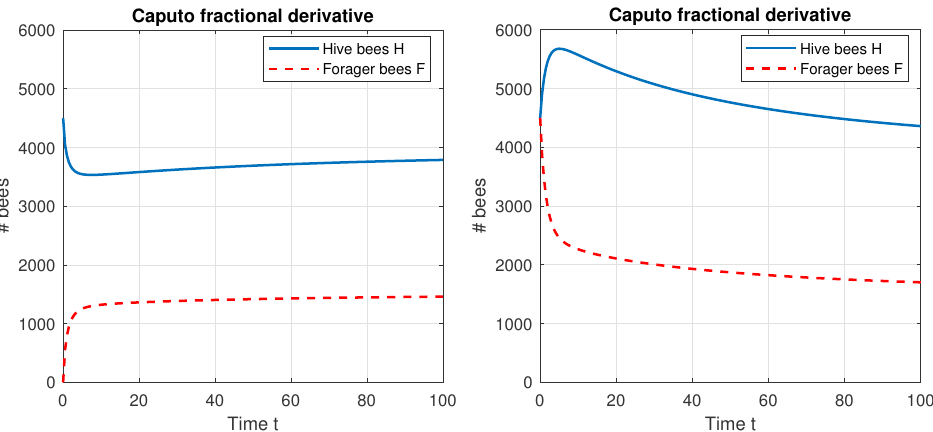
Figure 1. The colony population size for H 0 = 4500: F 0 = 0 ( left ), F 0 = 4500 ( right ), modeled by the Caputo derivative (3a)–(3c).